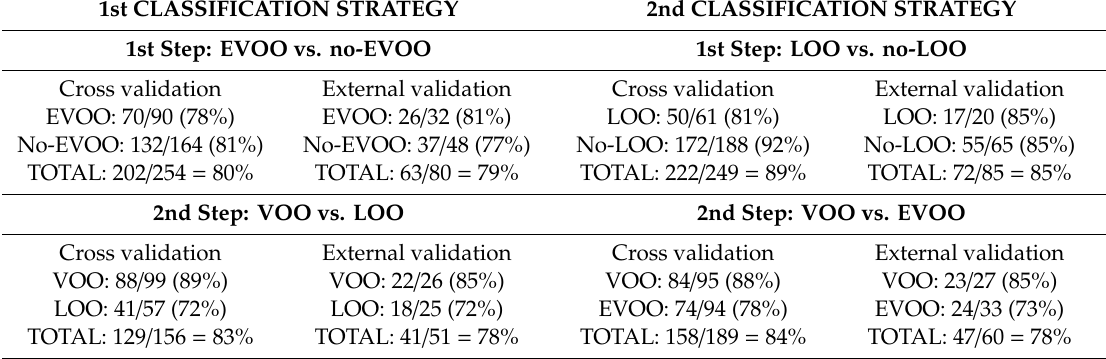
Figure 2. Class prediction probability of all samples used to develop the models, in cross and external validation (grey area). Step 1—EVOO (green star) vs. no-EVOO (blue square); step 2—VOO (yellow diamond) vs. LOO (red circle); step 1—LOO (red circle) vs. no-LOO (yellow square); step 2—VOO (yellow diamond) vs. EVOO (green star). EVOO = extra virgin olive oil; VOO = virgin olive oil, LOO = lampante olive oil. Table 3. Results in terms of percentage and number of samples correctly classified in cross and external validation of the two classification strategies applied based on the partial least squares-discriminant analysis (PLS-DA) sequential model. EVOO = extra virgin olive oil; VOO = virgin olive oil, LOO = lampante olive